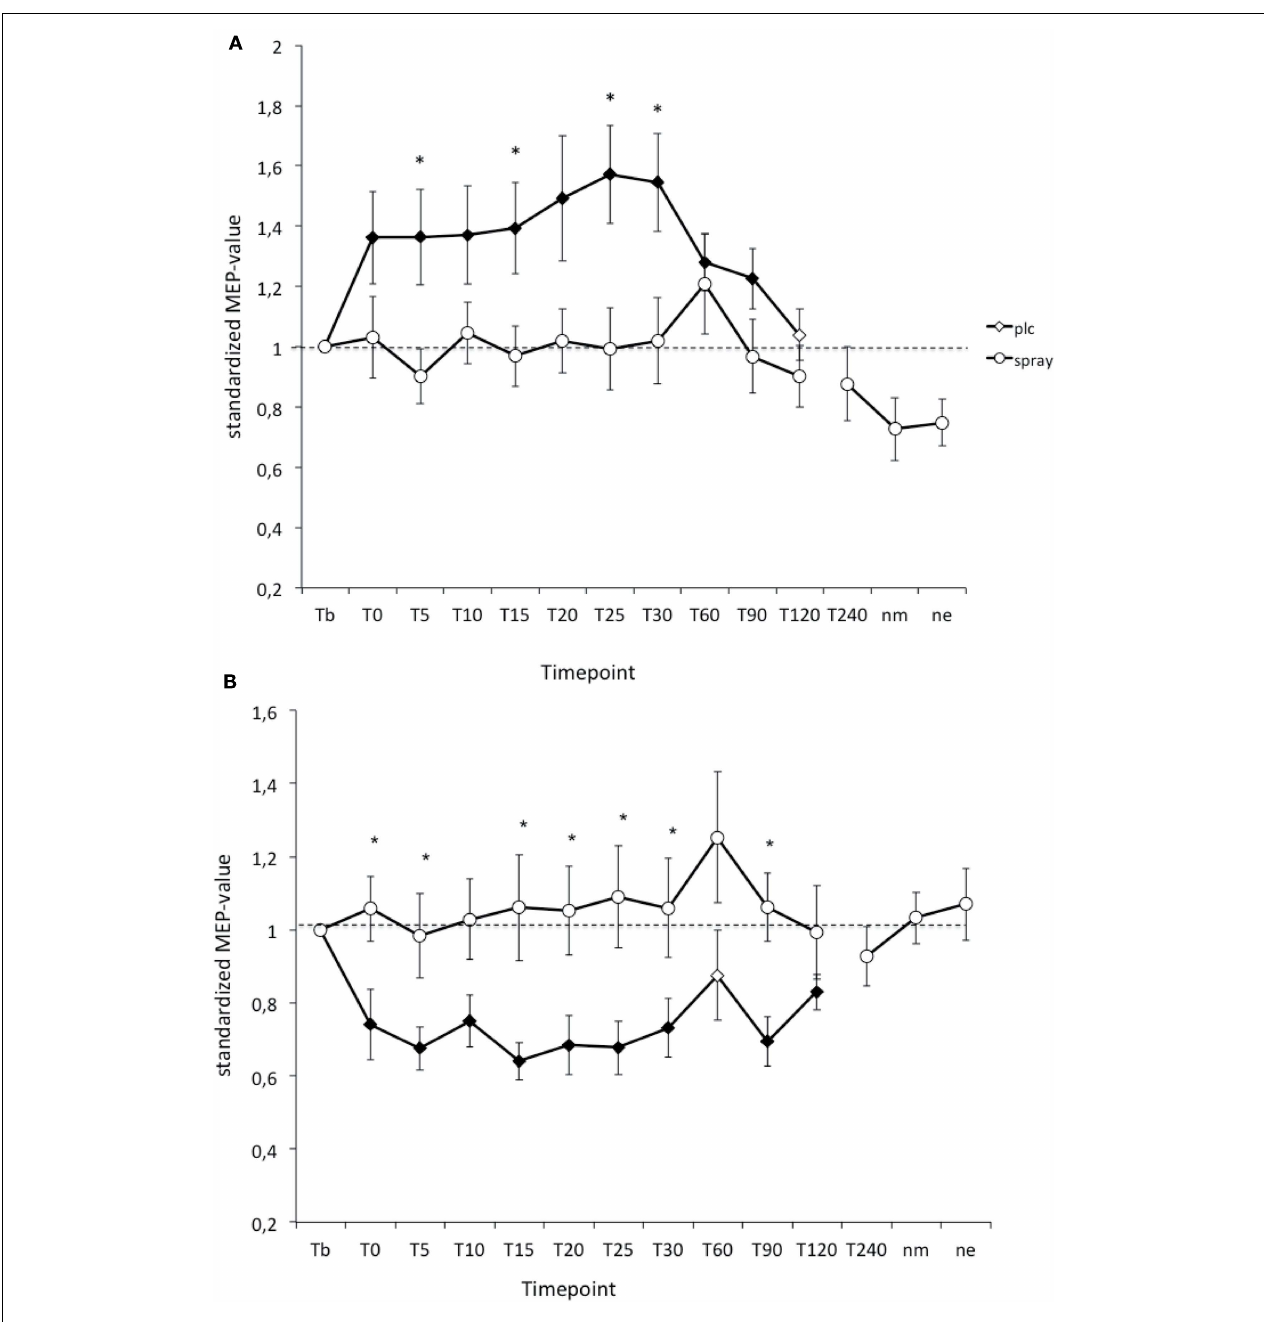
differences between the placebo medication and nicotine conditions (Student’s t -test, paired, two-tailed, p < 0.05). nm, Next morning; ne, next evening; plc, placebo.Tb, Baseline MEP-amplitude before begin of the stimulation protocols (standardized). Error bars indicate standard error of